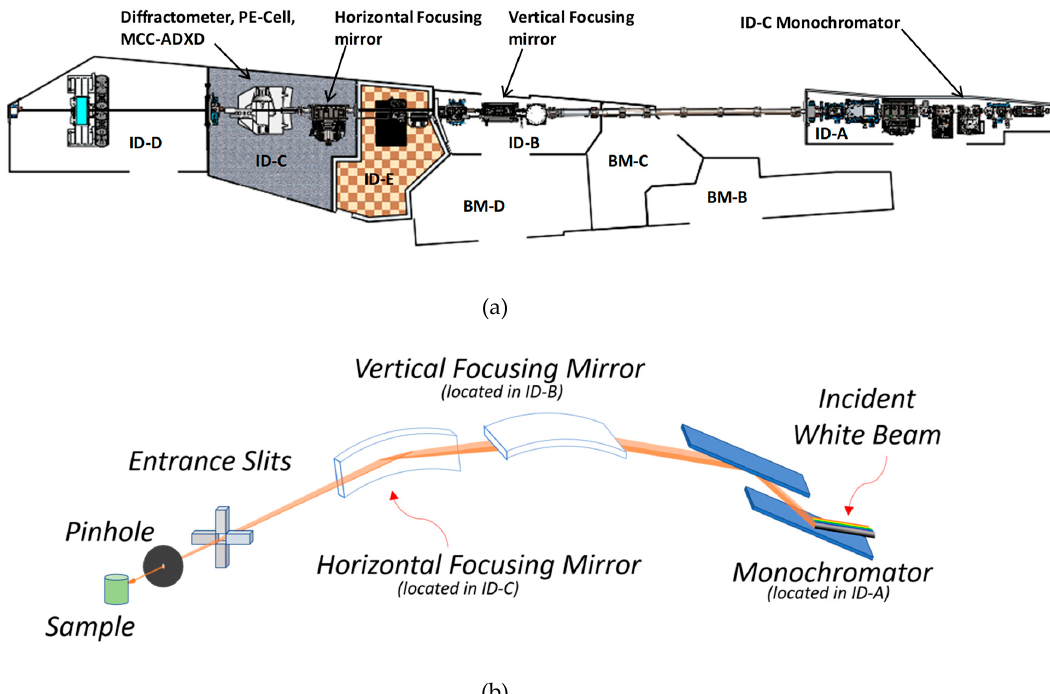
Figure 1. Current layout of the GeoSoilEnviro Center for Advanced Radiation Sources (GSECARS) bending magnet (BM) and insertion device (ID) beamlines ( a ). X-ray optics of the ID beamlines are mainly installed in ID-A and ID-B hutches. The diffractometer that hosts the Paris-Edinburgh press + multi-channel collimator setup is located in the ID-C hutch (labeled: MCC-ADXD in the gray colored area). ( b ) is a sketch of the experimental setup showing the doubly focused mono beam passing through the entrance slits, pin hole then entering the sample in the Paris-Edinburgh press.